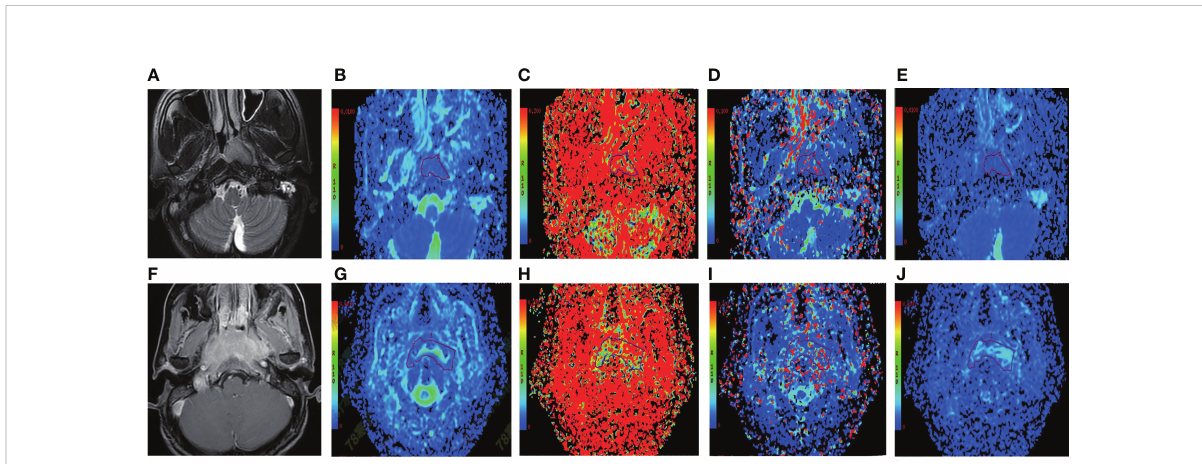
FIGURE 2 Representative T2WI and IVIM-DWI images from two NPC patients with different outcomes. (A – E) Images of a patient (case A) who suffered local failure. (A) Pretreatment T2WI. (B – E) Pretreatment ADC, f, D*, and D maps, respectively. The ADC, f, D*, and D values of the nasopharyngeal tumor in case A were 0.666 × 10 − 3 mm 2 /s, 0.354%, 3.78 × 10 − 3 mm 2 /s, and 0.581 × 10 − 3 mm 2 /s, respectively. The bottom row shows images from a patient (case B) who did not suffer local failure. (F) Pretreatment T2WI. (G – J) P retreatment ADC, f, D*, and D maps. The ADC, f, D*, and D values of the nasopharyngeal tumor in case B were 1.24 × 10 − 3 mm 2 /s, 0.192%, 17.9 × 10 − 3 mm 2 /s, and 0.927 × 10 − 3 mm 2 /s, respectively. IVIM-DWI, intravoxel incoherent motion diffusion-weighted imaging; ADC, pure diffusion coef fi cient; f, perfusion fraction; D*, pseudo-diffusion coef fi cient;